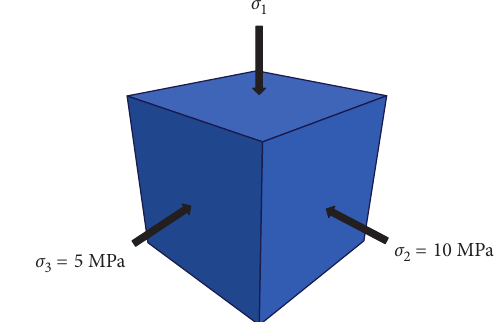
Figure 6: Model boundary condition diagram.